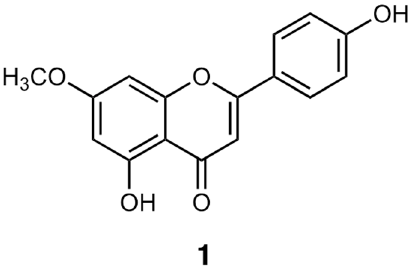
Figure 1. The chemical structure of Genkwanin ( 1 ).